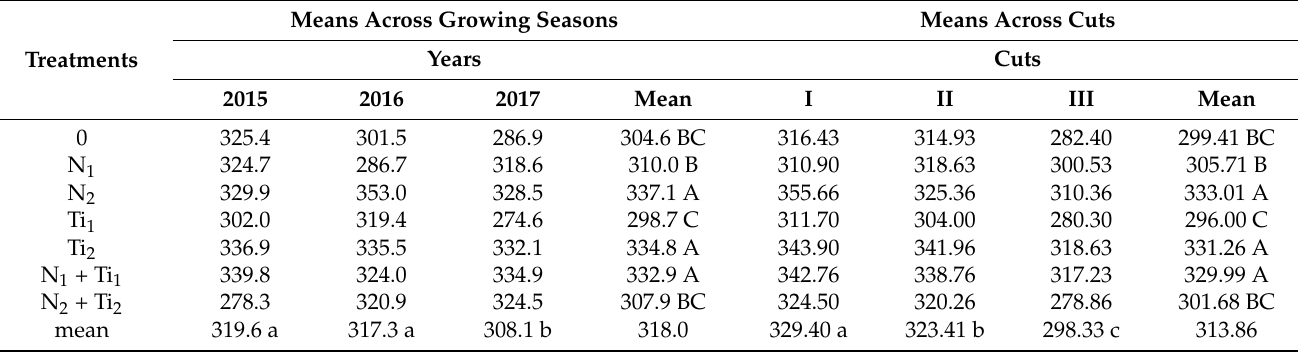
Table 2. Cellulose content in Festulolium braunii dry matter (g kg − 1